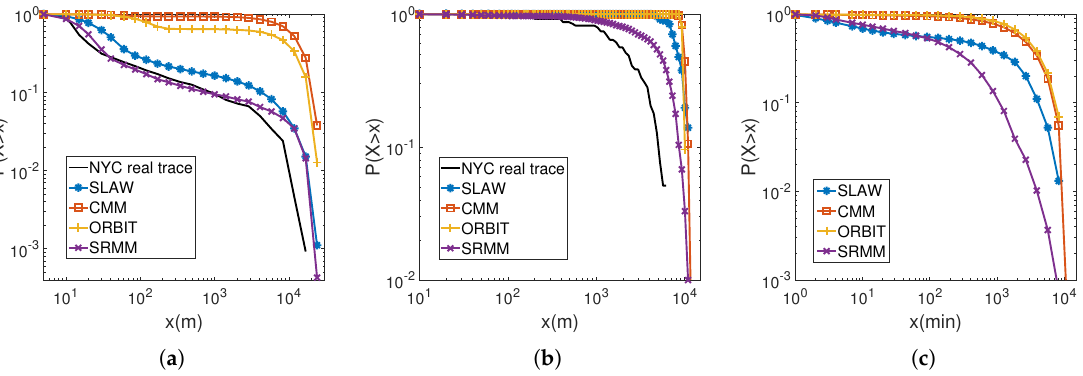
Figure 6. ( a ) Flight distributions of various models with the synthetic map. ( b ) The radius of gyration distributions of various models with the synthetic map. ( c ) ICT distributions of various models with the synthetic map. Table 3. KL divergence, P value of K-S test, and WMRD between the real trace distributions (flight distribution and radius of gyration distribution) and the distributions generated by the synthetic models shown in Figure 6a,b.